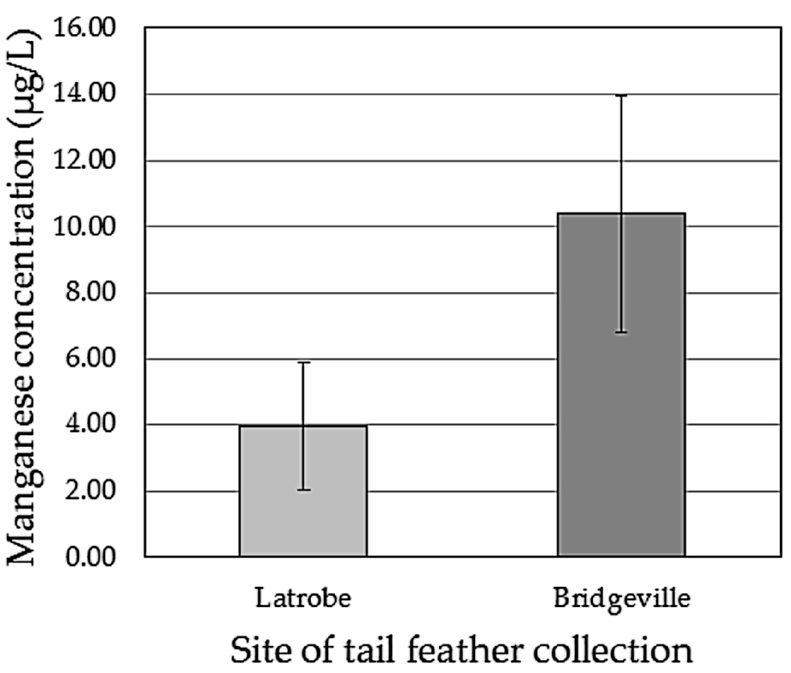
Figure 2. Average ( ± SD) concentration of manganese found in outer tail feathers collected from Tufted Titmice captured at Latrobe, Pennsylvania, 4 km and upwind from a steel plant, and Bridgeville, Pennsylvania, 0.3 km and downwind from a different steel plant. Eight birds per group. Concentrations were calculated from the amount of manganese present in 15.0 mL sample tubes after acid digestion. Manganese was found in significantly higher amounts in the Bridgeville population.